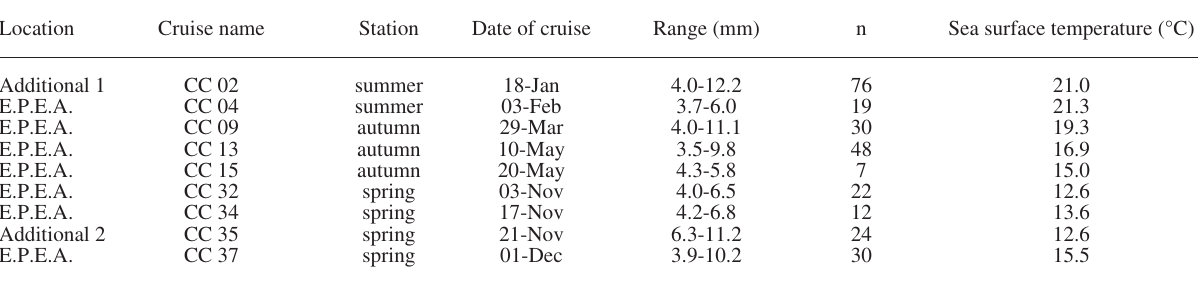
Table 1. – Sampling data, number of larvae analysed and sea surface temperature.